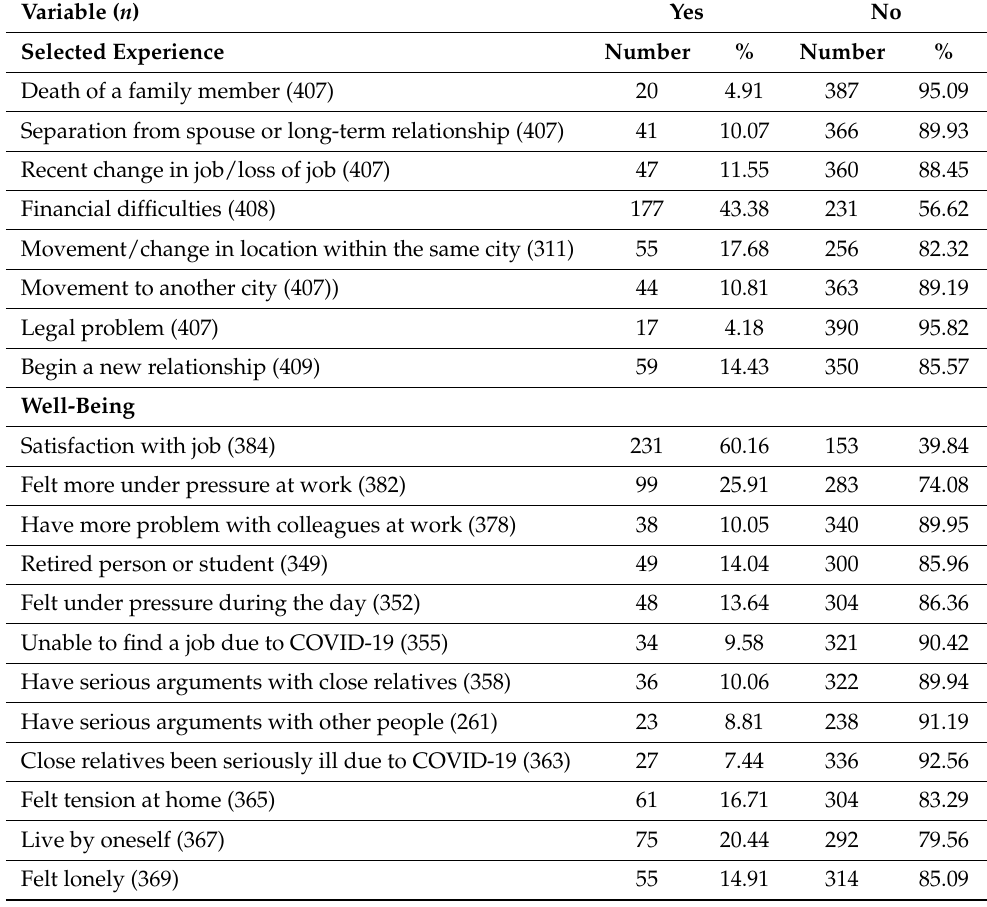
Table 3. Self-rated impact of COVID-19-related selected experience and well-being of respondents. Variable ( n ) Yes Selected